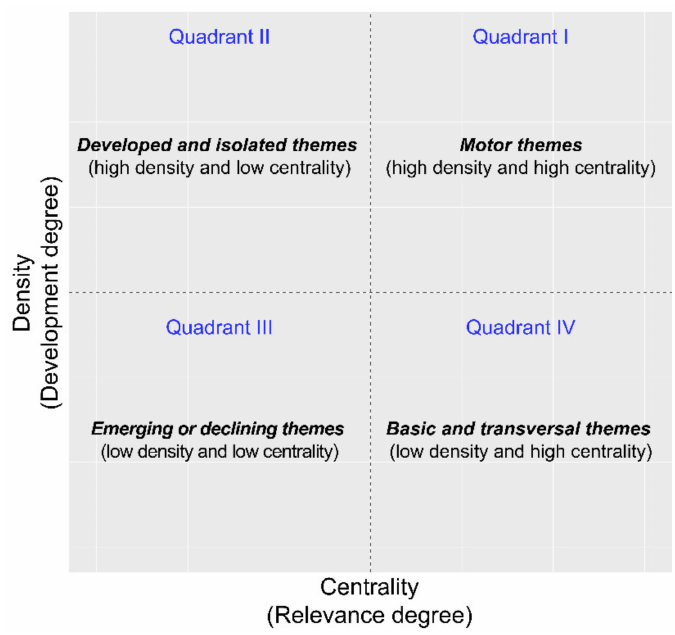
Figure 1. Strategic diagram modified from Cobo et al.